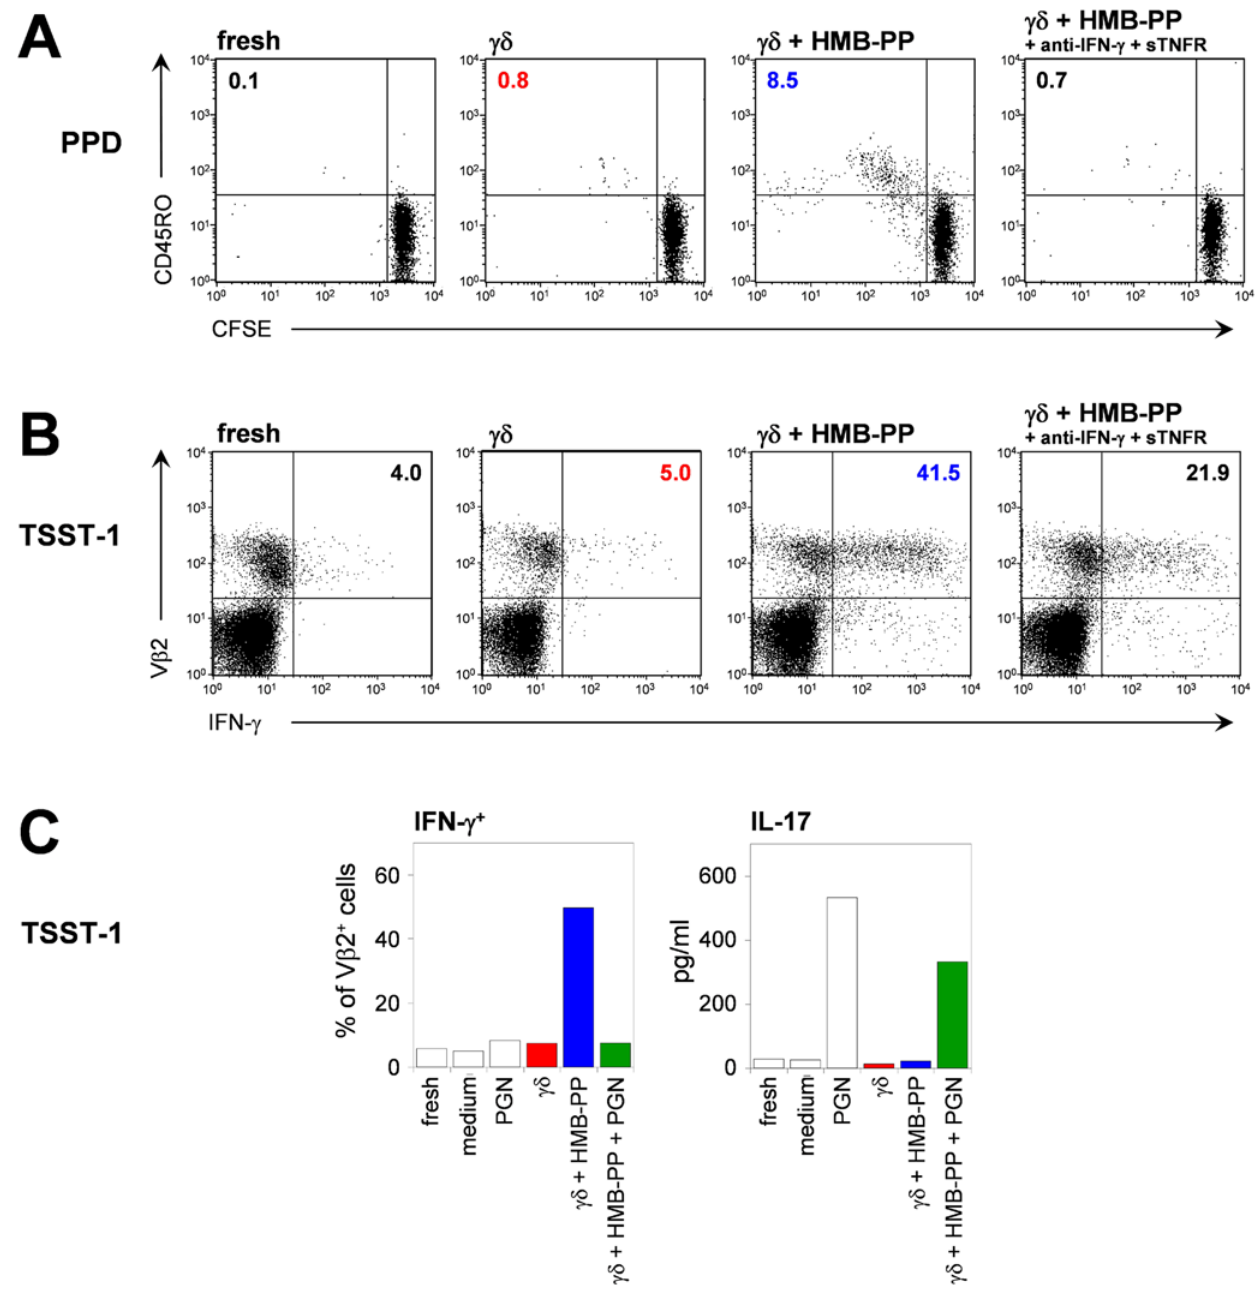
Figure 7. V c 9/V d 2 T cell-activated monocytes present bacterial antigens to autologous ab T cells. ( A ) Freshly isolated monocytes, or activated monocytes generated for 18 hours under the conditions indicated were used as APCs and incubated with CFSE-labeled naı¨ve ab T cells in the presence of PPD. CFSE dilution and CD45RO expression was measured after a further 96 hours of culture. Dot plots are gated on total CD3 + T cells; numbers indicate the percentage of CFSE lo CD45RO + T cells. ( B ) Freshly isolated monocytes, or activated monocytes generated as above were loaded with TSST-1 and used as APCs for ab T cells. Intracellular cytokine expression in responder T cells was measured after 72 hours of culture. Dot plots are gated on total CD3 + T cells; numbers indicate the percentage of V b 2 + T cells expressing IFN- c . No cytokine expression occurred in the absence of TSST-1. ( C ) IFN- c and IL-17 production by naive CD4 + T cell cultures in the presence of TSST-1-pulsed freshly isolated monocytes or monocytes pre-treated under the conditions indicated, as detected after 72 hours by intracellular staining for IFN- c (gated on TCR-V b 2 + T cells) and ELISA for IL-17. Data in A – C are representative of two experiments performed. doi:10.1371/journal.ppat.1000308.g007 effects on monocytes included enhanced survival; production of control of anti-microbial immunity. Our present findings demon- strate a reciprocal interaction between cd T cells and monocytes inflammatory cytokines and chemokines; and the development of within 18 hours, leading to the rapid induction of a remarkable DC-like characteristics, as evidenced by morphologic features, differentiation program in monocytes. The cd T cell-mediated expression of APC markers, uptake and processing of antigens,